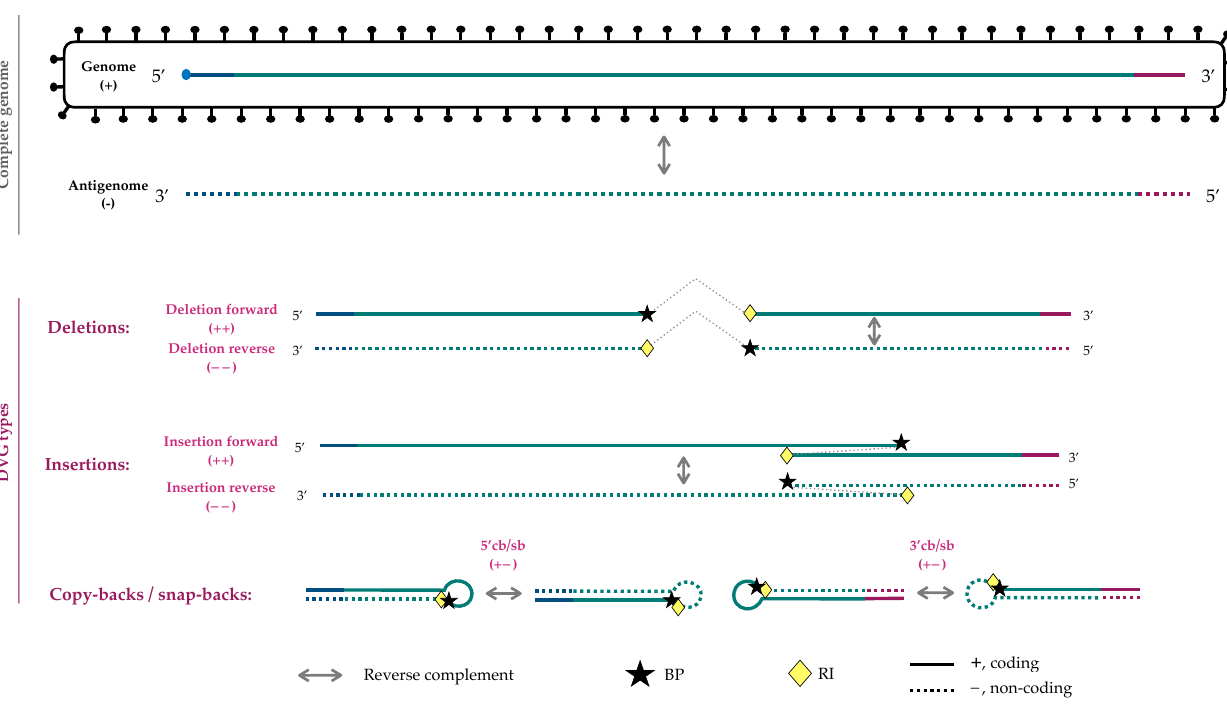
Figure 1. Schematic representation of the different types of DVGs that can be produced during a positive-sense RNA virus replication. In the case of negative-sense RNA virus, the terminology has to be reverted accordingly: coding (+) by non-coding ( − ), 5 (cid:48) cb/sb by 3 (cid:48) cb/sb, and “forward” by “reverse” and vice versa